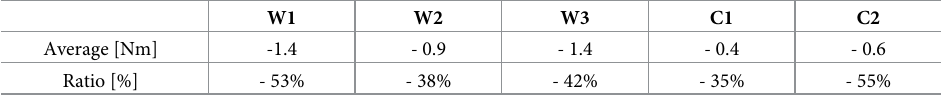
Table 9. Average difference joint torque between fixed weight and algorithm cases.